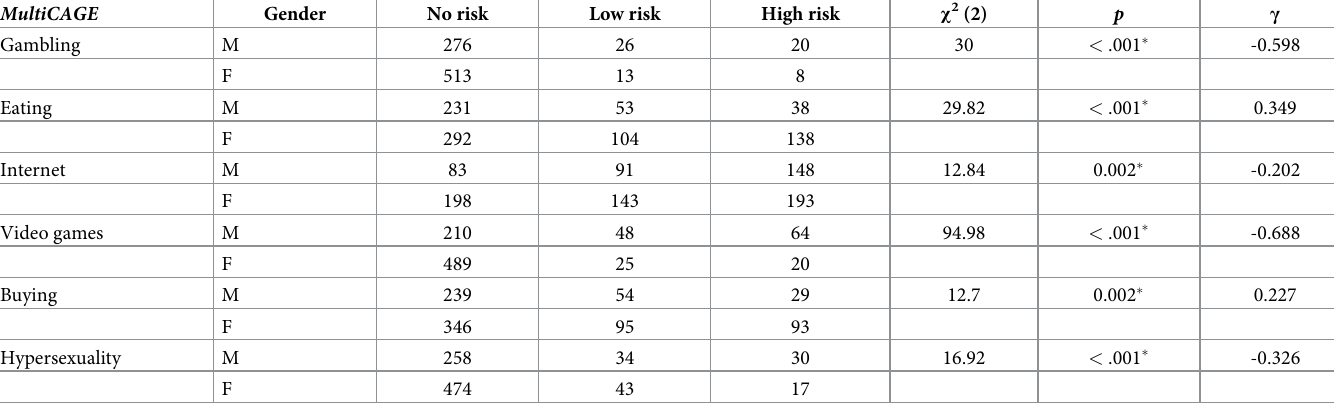
Table 1. Number of males and females in each of the three ranges (0: No risk, 1: Low risk, 2–4: High risk) of MultiCAGE scales for non-substance potentially dysre- gulated/addictive behaviors, results of a χ 2 test on the relationship between gender and MultiCAGE level of risk, and gamma ( γ ) coefficient of ordinal correlation (positive values stand for a higher incidence of risky behaviors in